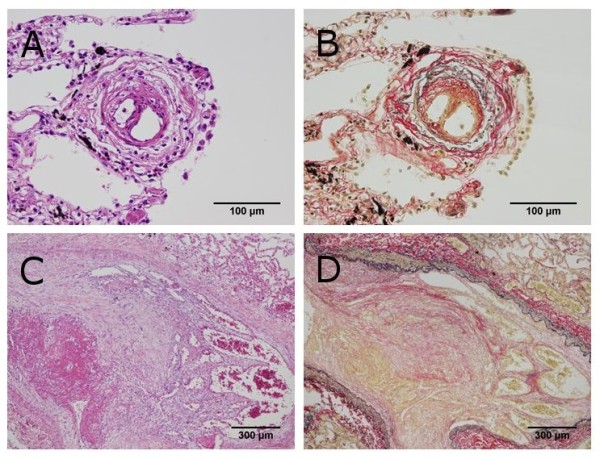
Histopathological findings of pulmonary tumor thrombotic microangiopathy in case 1. (A and B) Fibrocellular intimal proliferation occludes the lumen of the pulmonary artery under 100 μm in diameter (Hematoxylin-eosin (HE) double stain and elastica van Gieson (EVG) stain, × 400). (C and D) Fibrocellular intimal proliferation associated with carcinoma cells proliferation occludes the lumen of the pulmonary artery over 300 μm in diameter (HE double stain and EVG stain, × 40).